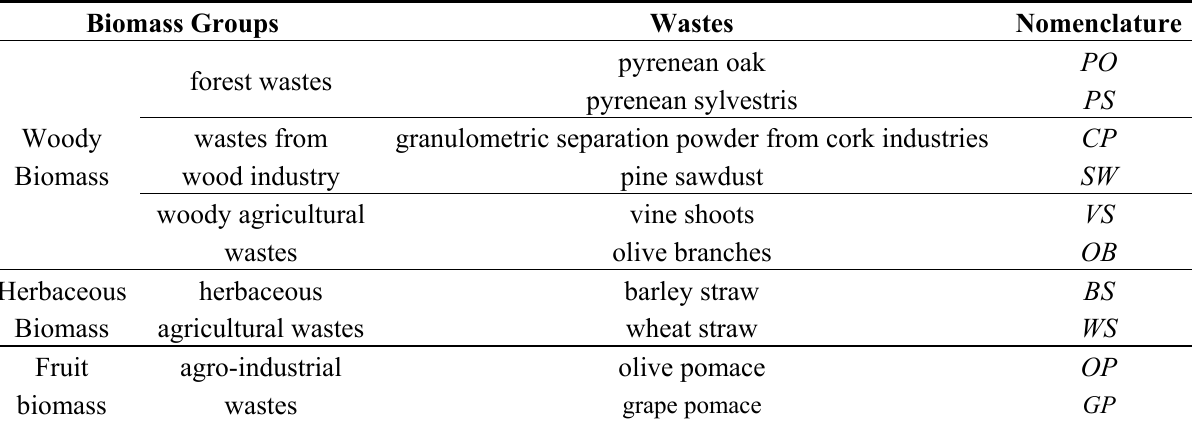
Table 1. Analyzed